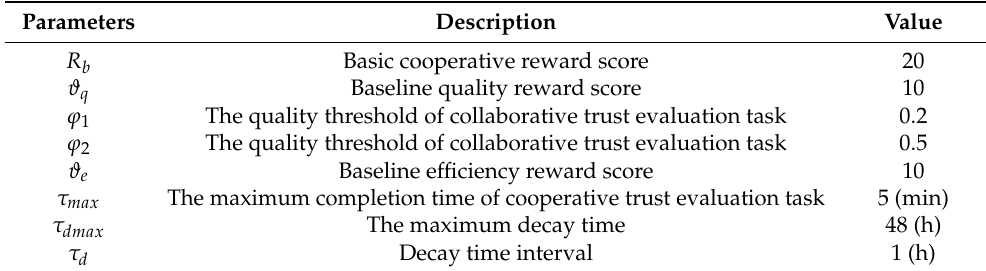
Table 3. Simulation Parameters.